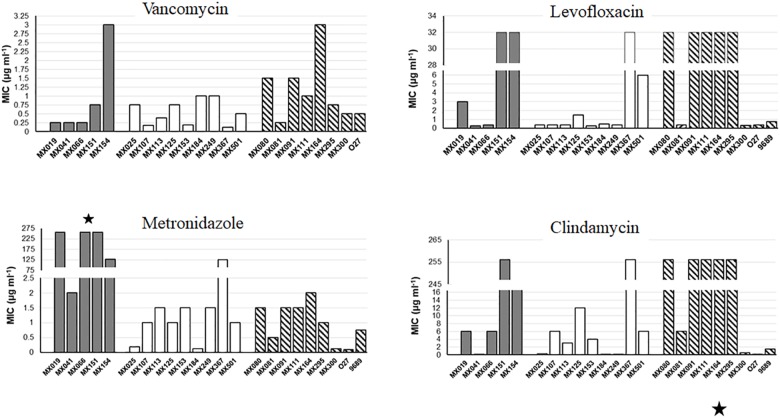
Antibiotic resistance of NTCD strains. E-Test analysis of NTCD strains. Gray bars: cdtB+tcdA+tcdB+ strains. White bars: cdtB−tcdA−tcdB− strains. Striped bars: control toxigenic strains. ∗p < 0.05.